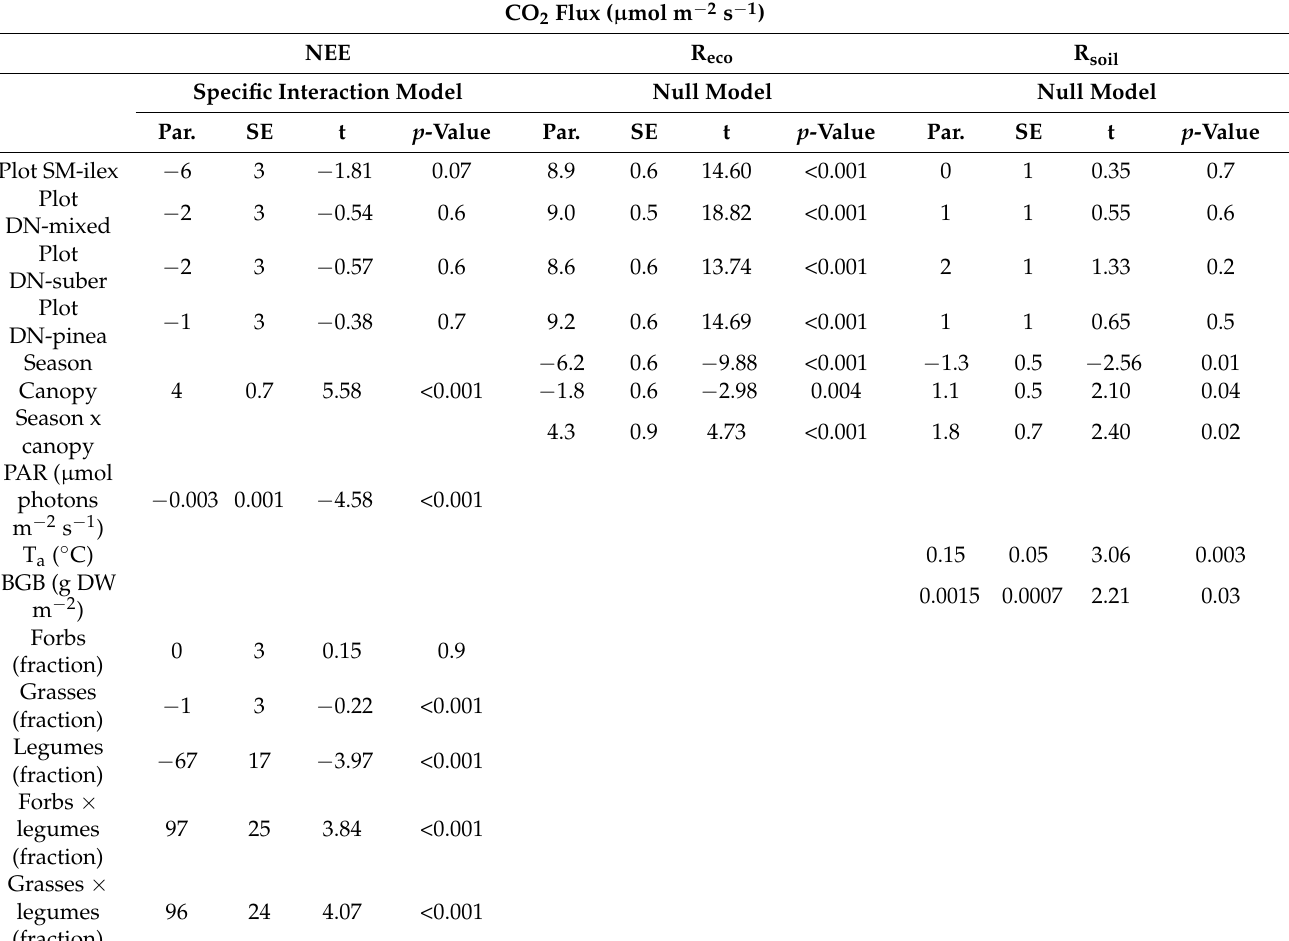
Table 2. CO 2 exchange diversity-interaction model results. Net ecosystem exchange (NEE), ecosystem respiration (R eco ), and soil respiration (R soil ) as function of plot, season, canopy, photosynthetically active radiation (PAR), air temperature (T a ), aboveground biomass (AGB), belowground biomass (BGB), and plant functional types (forbs, grasses, and legumes) proportions. Season with spring as reference level, and canopy with open grassland (OG) as reference level. Parameter estimates (Par.), standard error (SE), t, and p